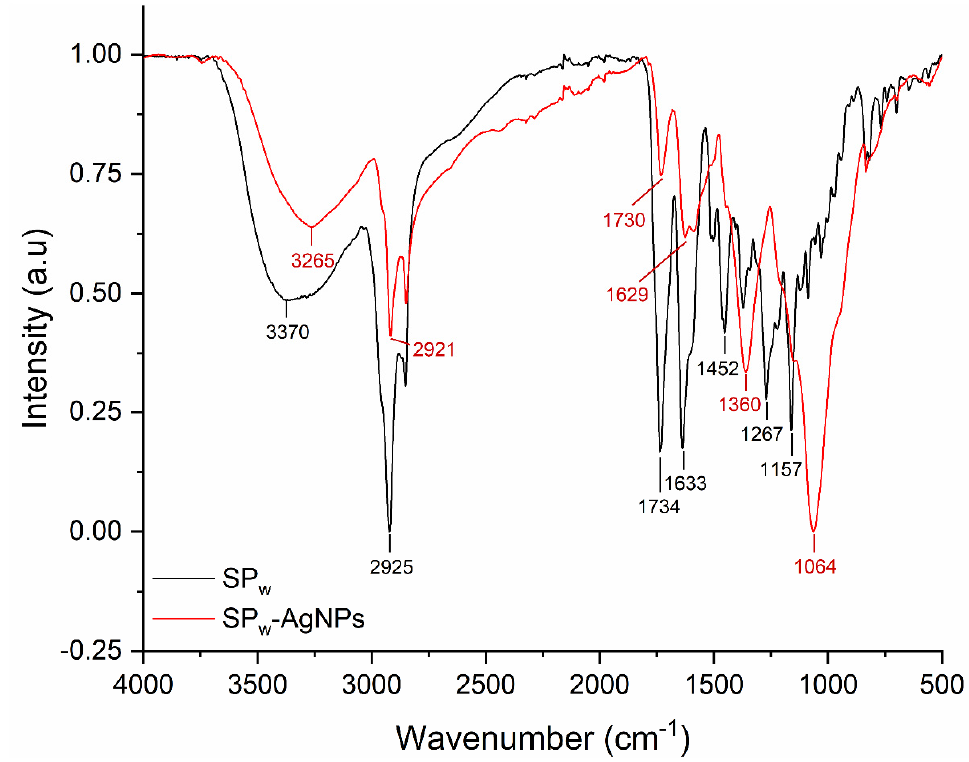
Figure 4. FT-IR spectra of SPw (black line) and SPw-AgNPs (red